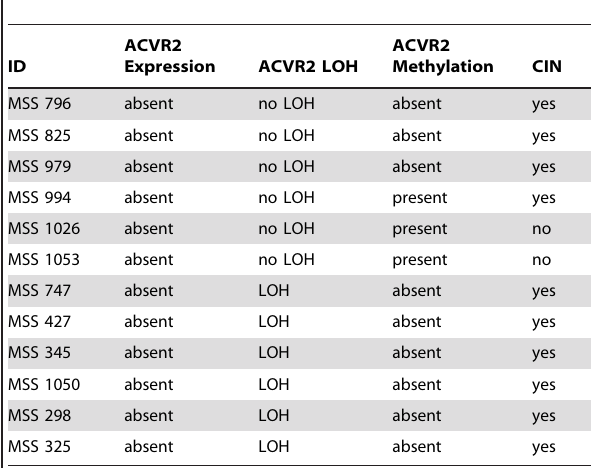
Table 2. Mechanisms of ACVR2